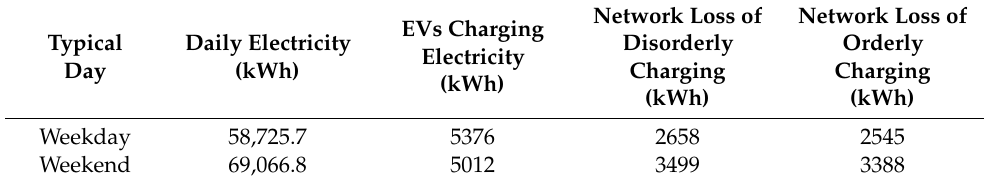
Table 5. Comparison of the network loss between orderly charging and disorderly